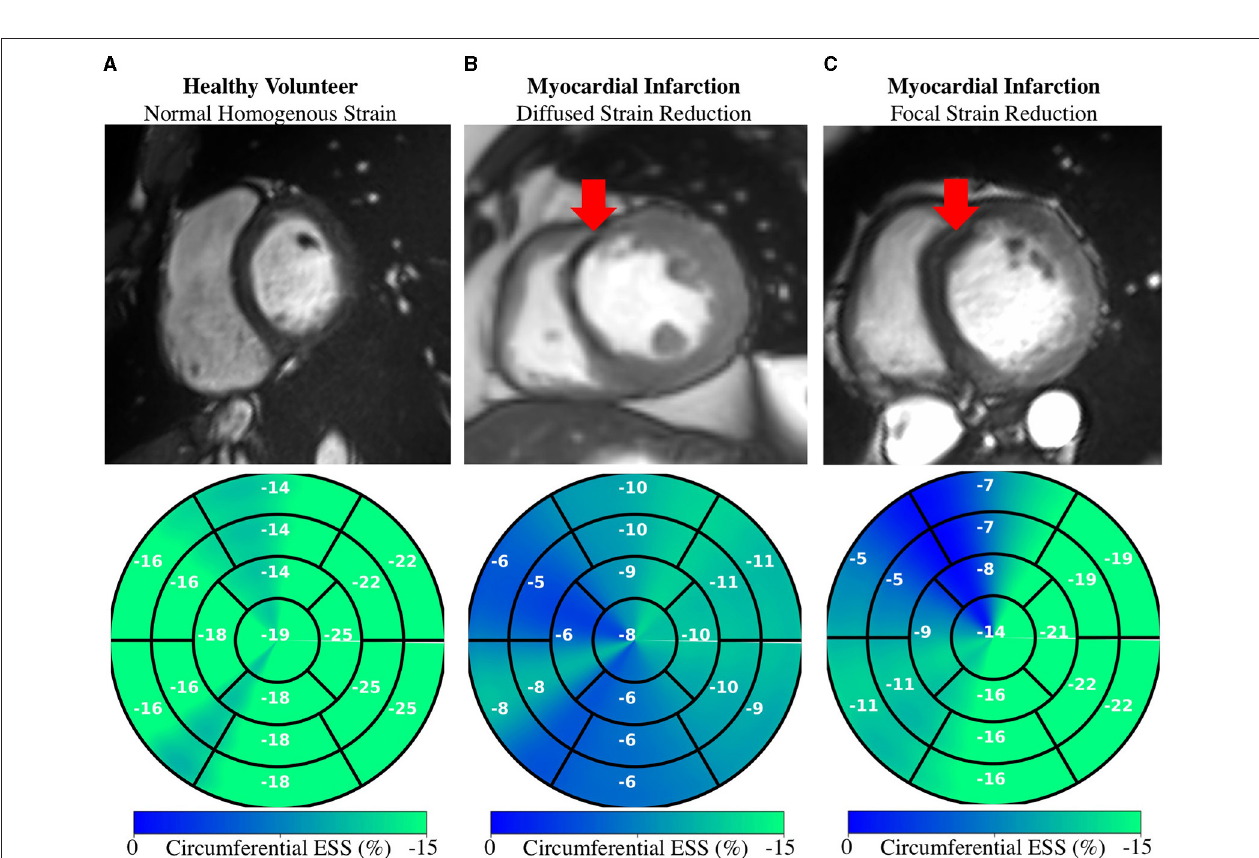
FIGURE 7 | Strain measures on the ACDC train set. Radial strain (Left) and strain rate (Right) across time is shown for healthy subjects and patients with hypertrophic cardiomyopathy (HCM), abnormal right ventricle (ARV), myocardial infarction (MI), and dilated cardiomyopathy (DCM).